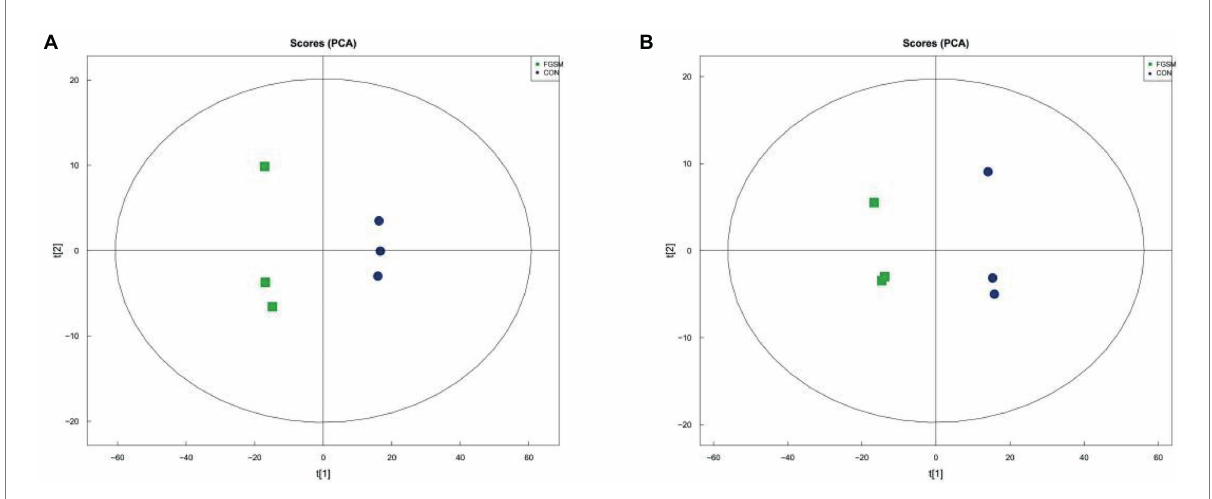
FIGURE 1 The principal component score plot analysis (PCA) of FGSM. (A) PCA plot in positive-ion mode; (B) PCA plot in negative-ion